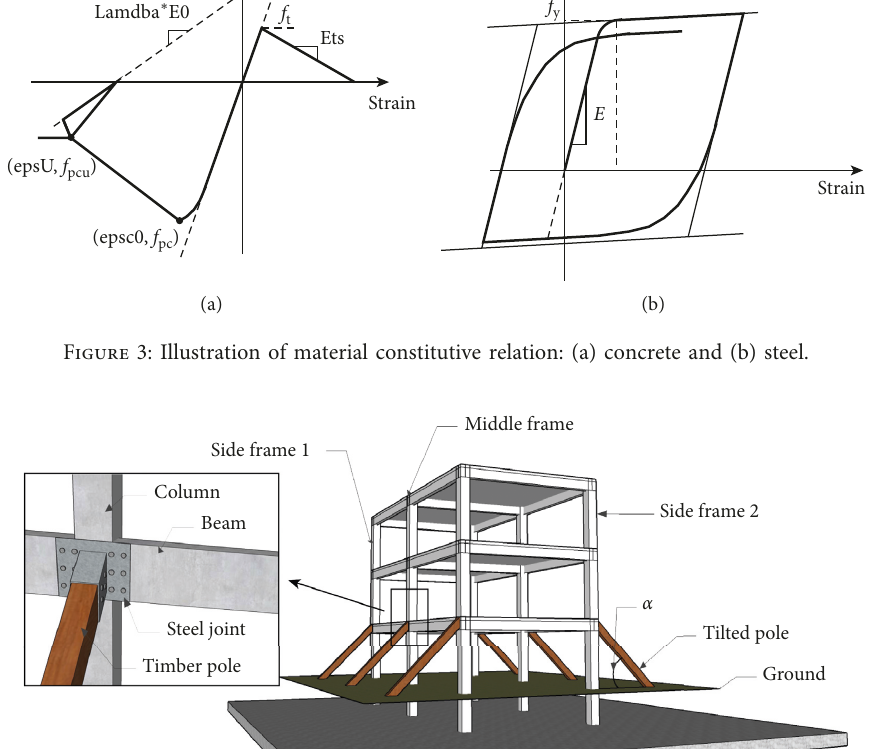
Figure 4: Schematic of support scheme.